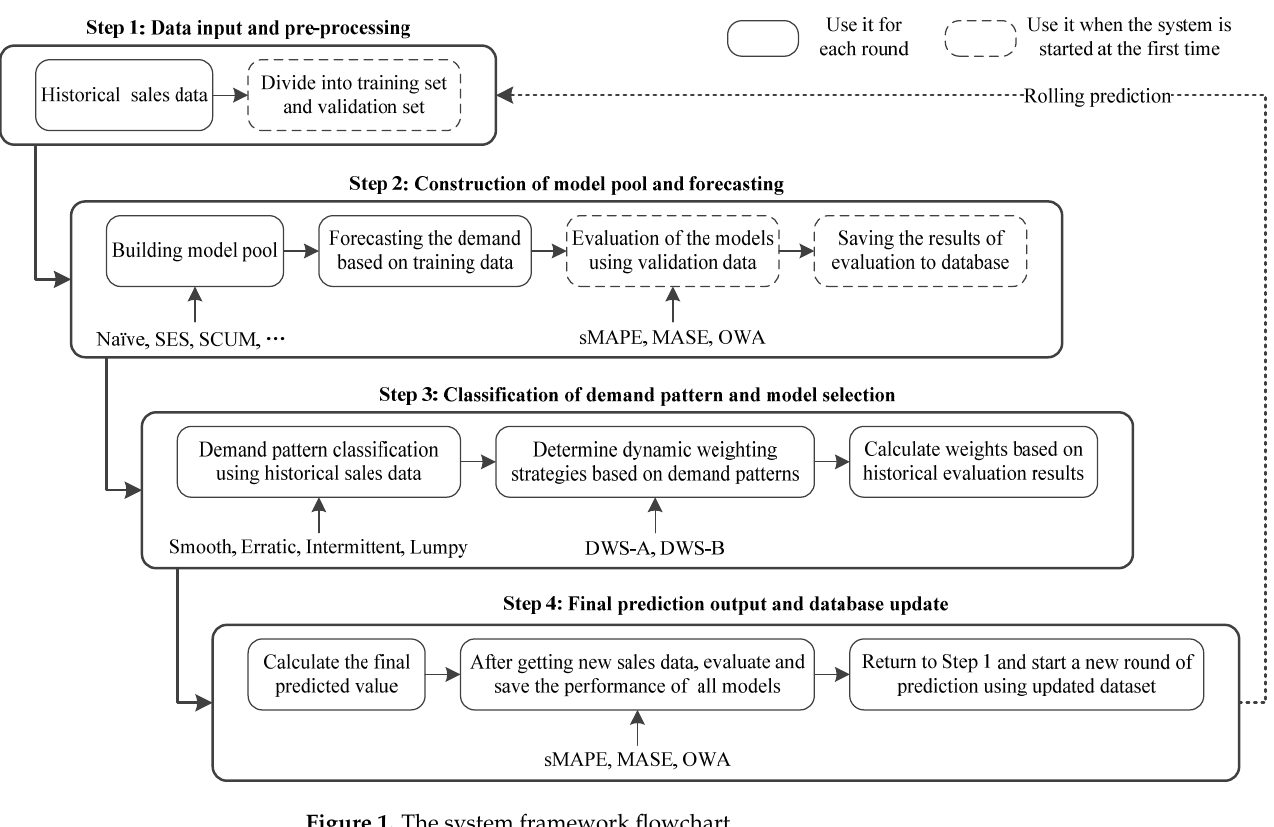
Figure 1. The system framework